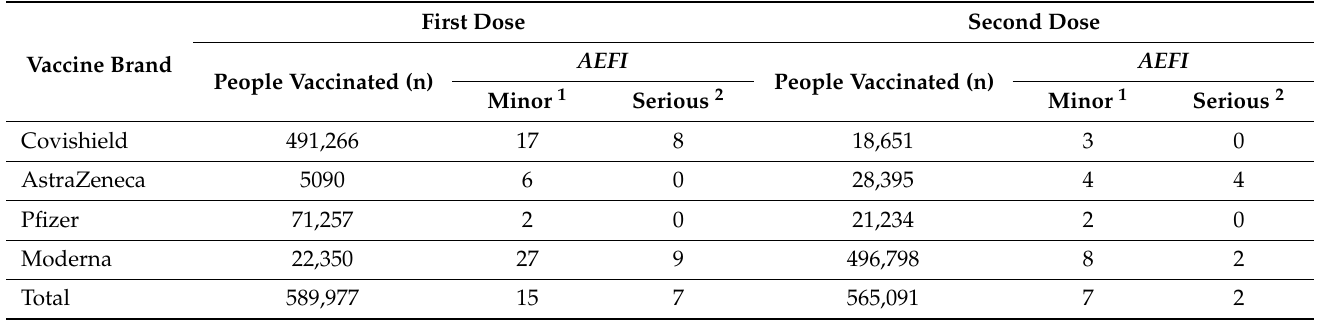
Table 1. Adverse Events Following Immunization rate for the first and second dose against different vaccines.